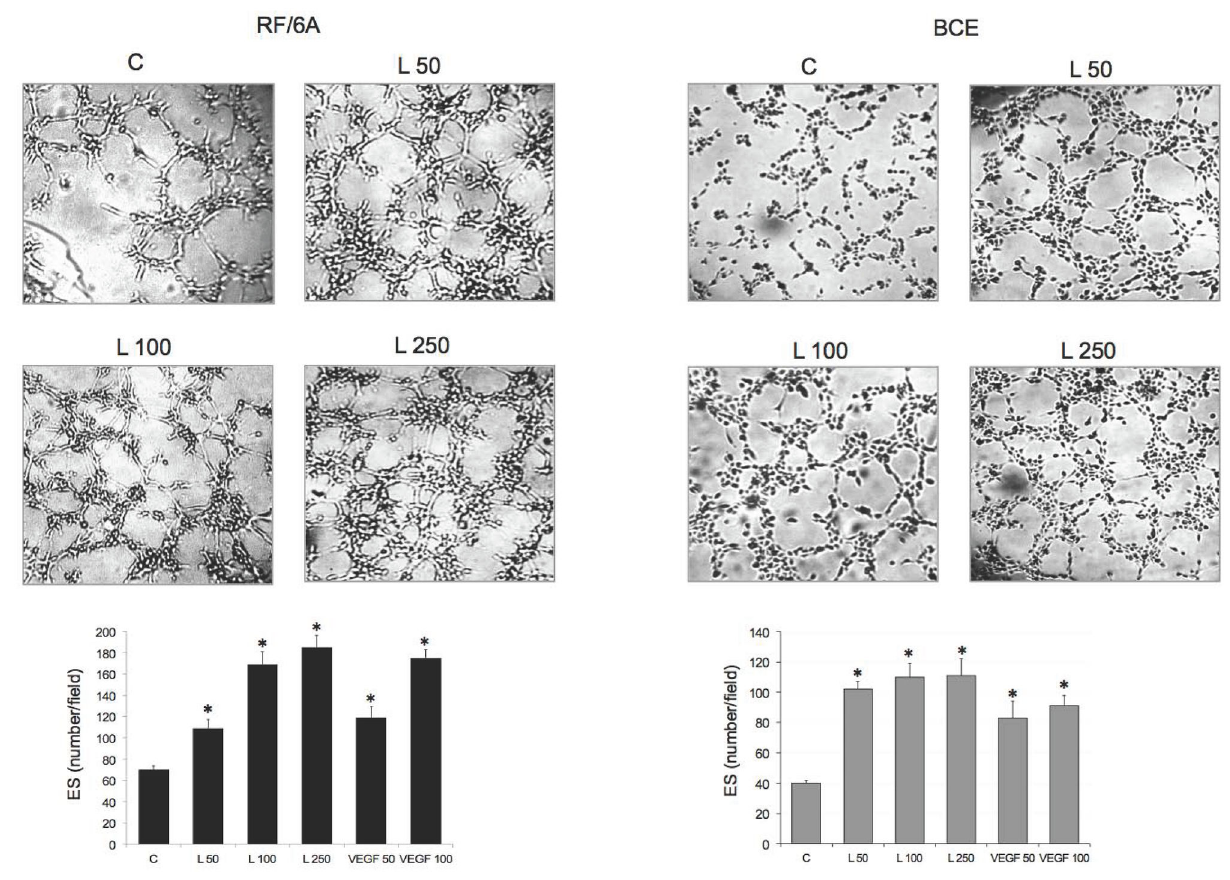
Figure 3. Effects of leptin on angiogenic response in RF/6A and BCE cells. The assays were carried out as described in Materials and Methods. The photographs represent ES formation in RF/6A and BCE cultures under different treatments: SFM (C), 50-250 ng/mL leptin (L), 50 and 100 ng/mL VEGF (central field of the well at 5x magnification is shown). The graph shows the number of ES (±SD) per visual field. Asterisks indicate significant (p≤0.05) differences vs. SFM.